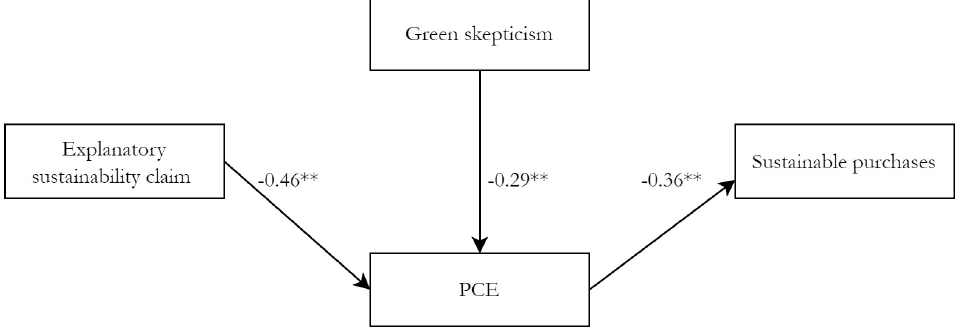
Figure 2. Final path model to test H1b through H3b (Model 1). Note: ** Relationship is significant at